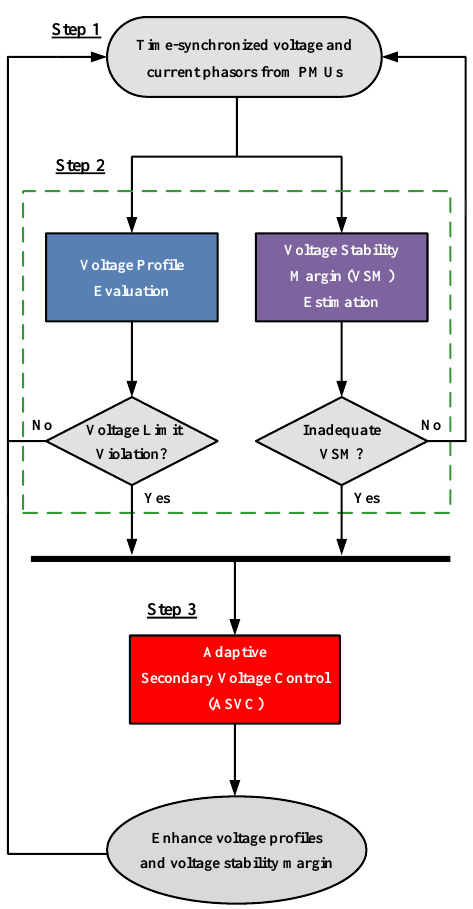
Figure 2. Flowchart of the proposed scheme.